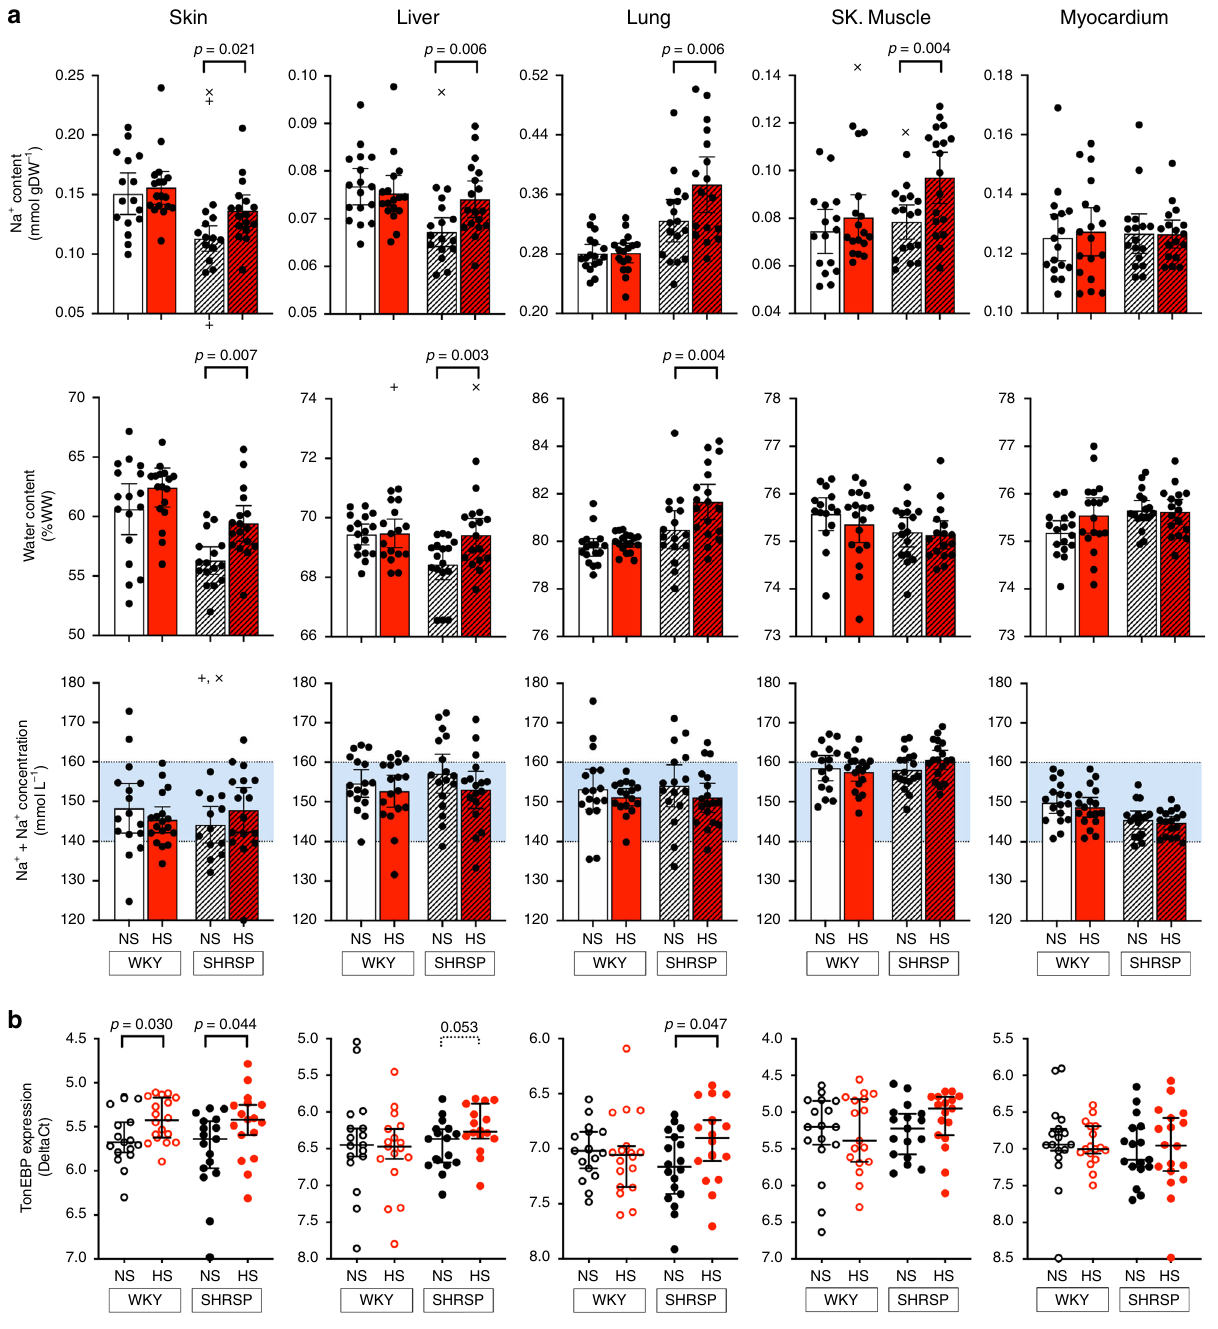
Fig. 2 Nature and distribution of tissue Na + excess and TonEBP expression upon salt loading. Panel a bars: empty = WKY , dashed = SHRSP , red = high salt (HS) treatment; all bars show mean ± 95% CI, with individual points (overlay; + and x: female and male automatically detected outliers, respectively; ROUT, Q = 1%); signi fi cant differences at prede fi ned comparisons are shown by brackets, on top (two-sided Fisher LSD test; please see also Supplementary Table 1 for sex-speci fi c data and detailed signi fi cance). Tissue Na + content increased in all tissues in SHRSP -HS, but in myocardium; with the exception of skeletal muscle, it was consistently paralleled by water accrual. Total Na + + K + concentration in tissues fell in physiological ranges (light blue) and was unaffected by salt loading in either strain, ruling out hypertonic accumulations. Panel b data presented as Delta Ct, median ± 95% CI for all rats; signi fi cant differences at two-sided Mann – Whitney test are shown in brackets. Increased TonEBP gene expression followed Na + and water accumulation despite no hypertonicity. For both panels, n = 16 – 18 animals/group, as per Supplementary Data 1; source data are provided as a Source Data fi